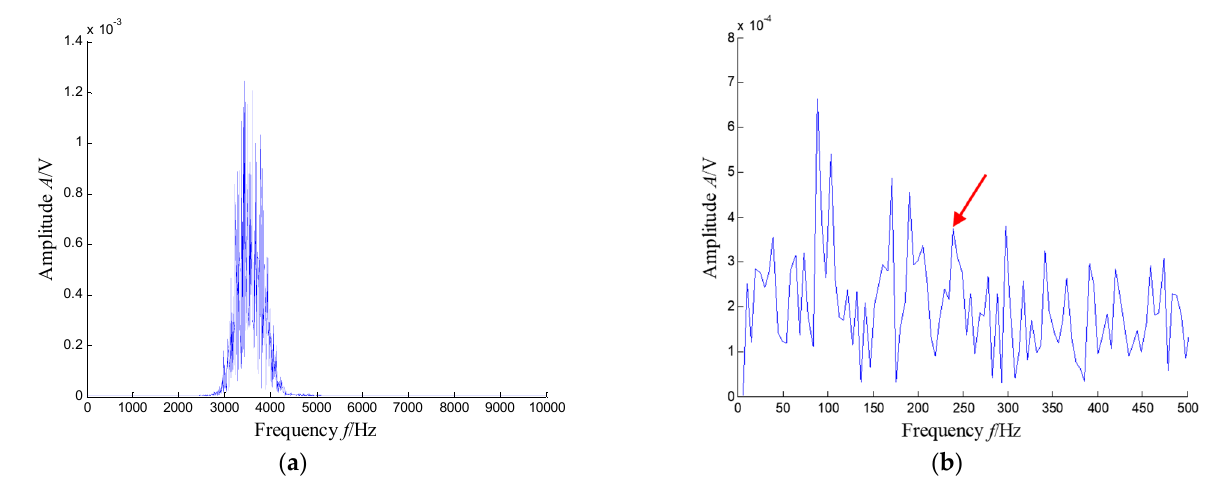
Figure 25. Spectrum and envelope spectrum of the extracted signal: ( a ) spectrum and ( b ) envelope spectrum (the fault characteristic f BPFO is highlighted by a red arrow).